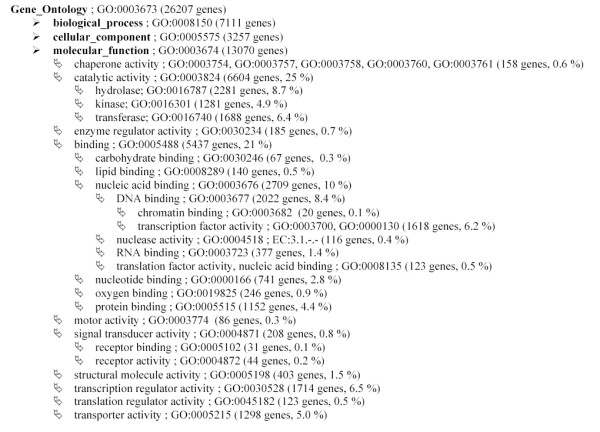
The distribution of genes in major categories of the Gene Ontologies. Each of the 26,207 protein coding genes was assigned to at least one GO term, with our primary focus the assignment of genes to Molecular Function terms. The ontology categories illustrated correspond to those of the plant GO slim obtained from